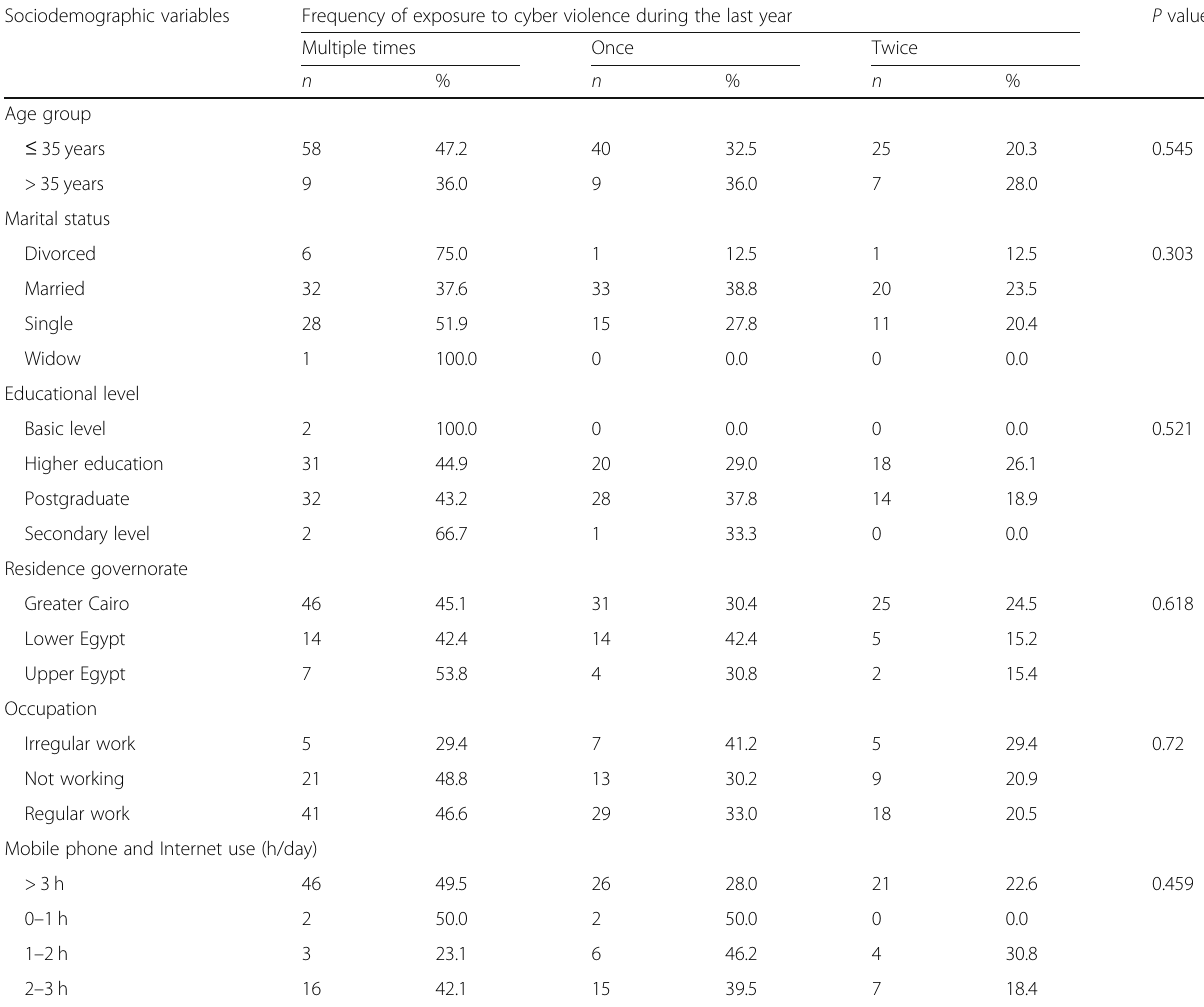
Table 6 Relation between sociodemographic data and frequency of exposure to cyber violence among participating females during the last year ( N = 148) Sociodemographic